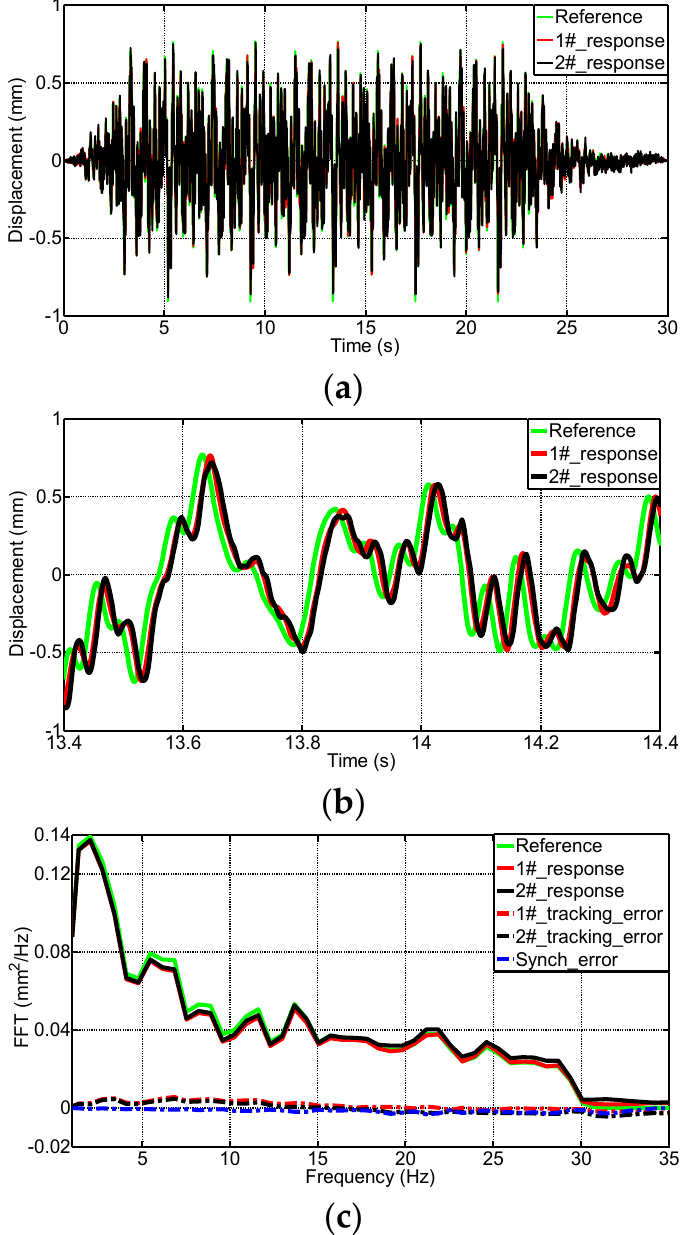
Figure 26. The results with proposed compound control. ( a ) Time domain; ( b ) Partial enlarged view of ( a ); ( c ) Frequency domain.